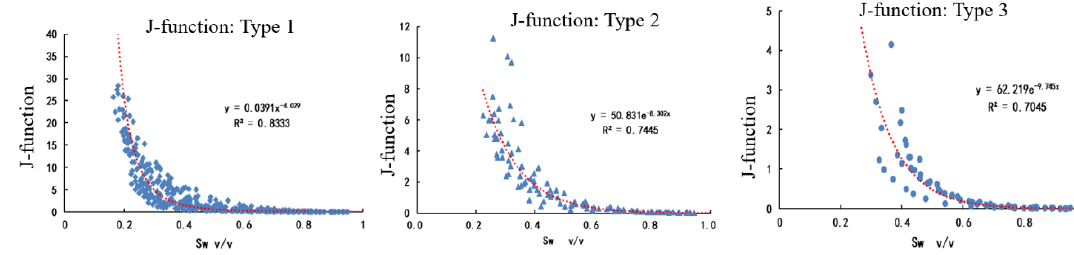
Figure 6. J-functions of grouped capillary pressure curves.